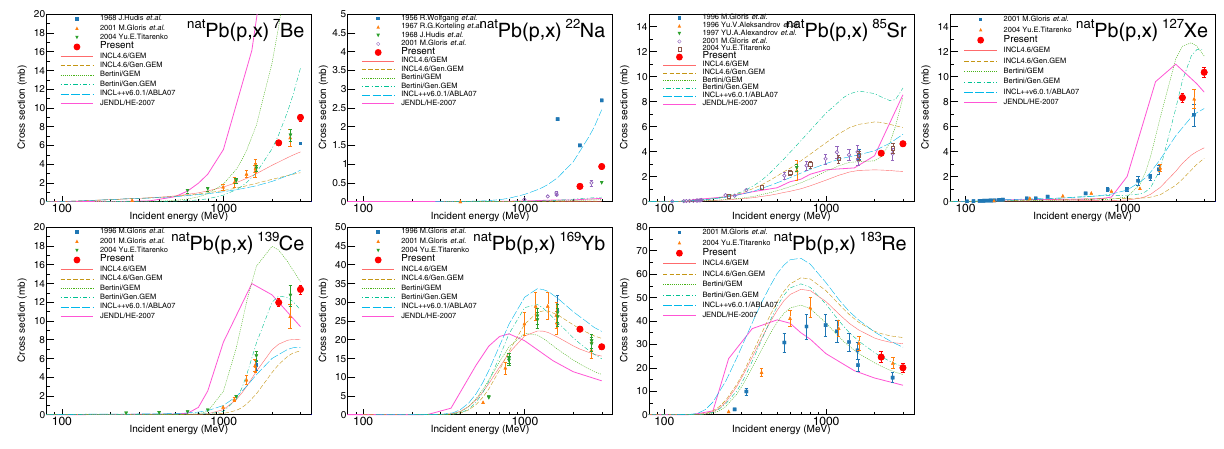
Figure 1. Production cross sections of 7 Be, 22 Na, 85 Sr, 127 Xe, 139 Ce, 169 Yb, and 183 Re from nat Pb. This works (full circle), other experiments (other symbols) taken from EXFOR, calculations (solid and dashed lines), and the evaluated data (bold line) are plotted.